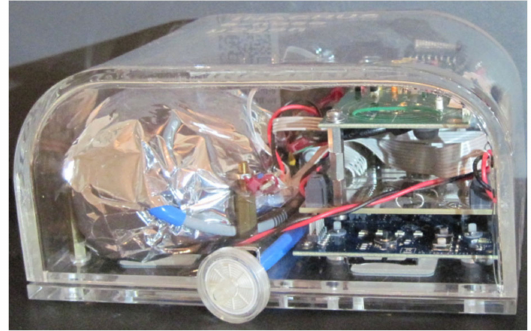
Figure 1. The detector device. On the left is the sensor cluster and on the right are the readout and control electronics. An air interface filter can be seen in the center of the